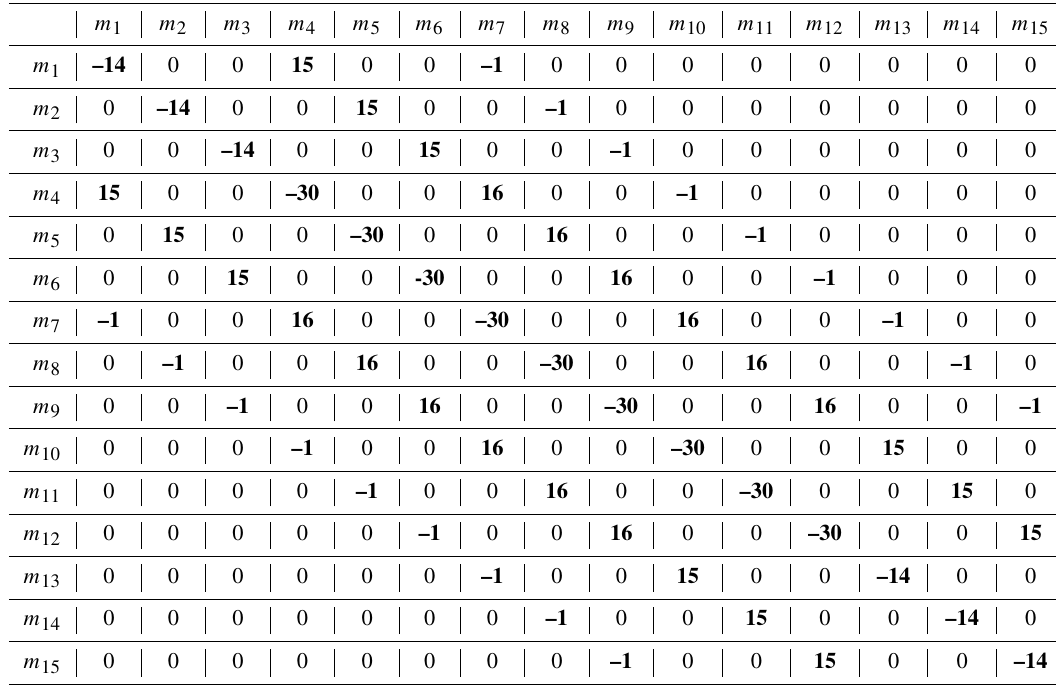
Table 2. A discretized derivative operator D xx × 12 h 2 for a 3 × 5